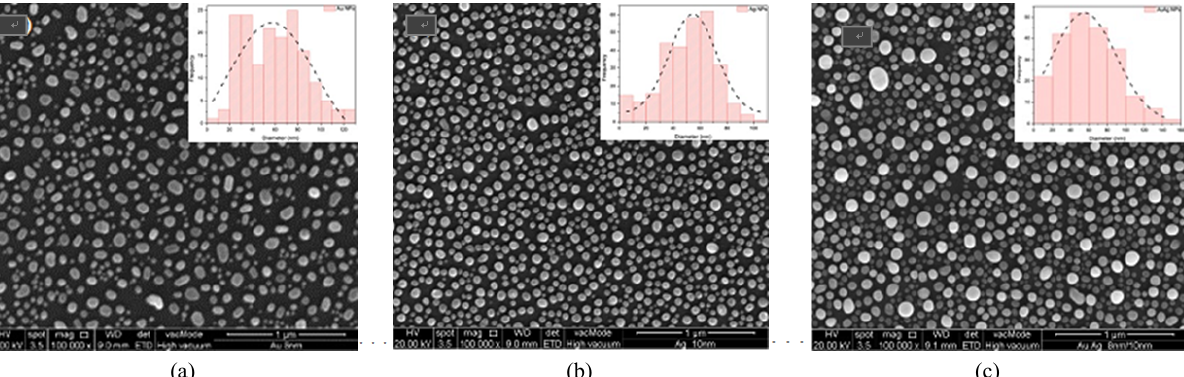
Fig. 2 FE-SEM images of (a) Au NPs, (b) Ag NPs, and (c) Au-Ag NPs. Inset images show the histogram distribution for each structure with the corresponding size of